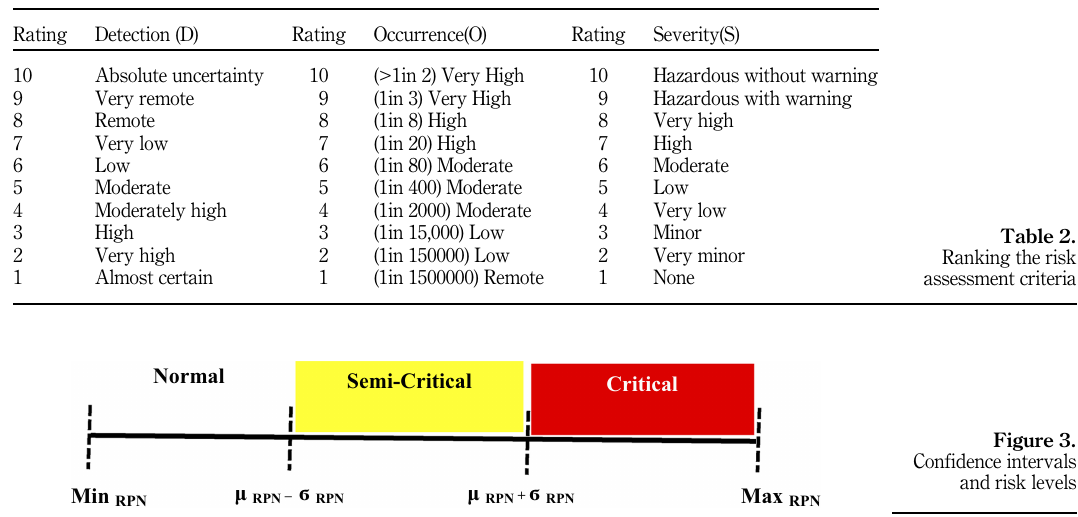
Figure 3. Confidence intervals and risk